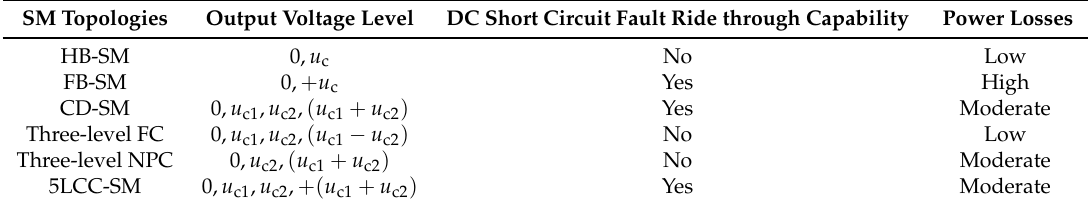
Table 2. Comparison of different SM